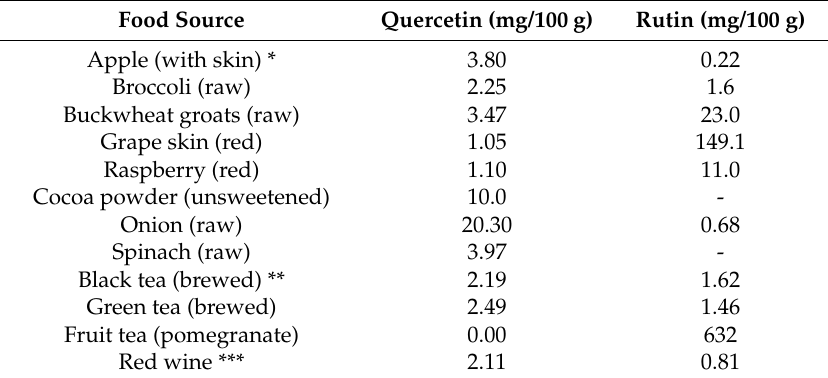
Figure 1. Chemical structure of flavonols: quercetin is the most abundant in the diet and is found in onions, broccoli, apples, tea and red wine. Table 1. Dietary quercetin and rutin-content in common foods